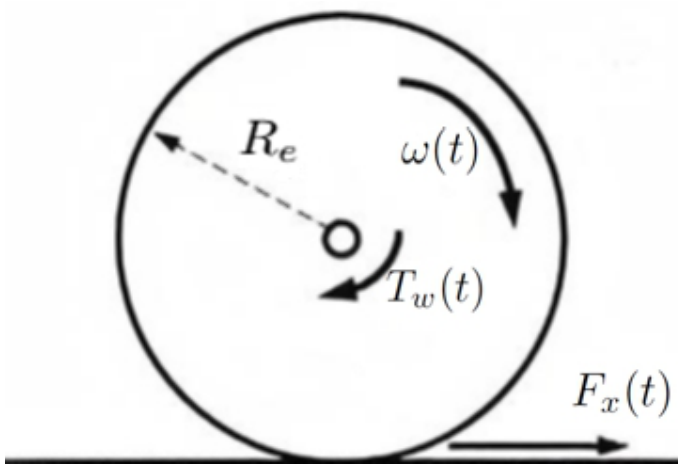
Figure 3. Basic dynamics of a